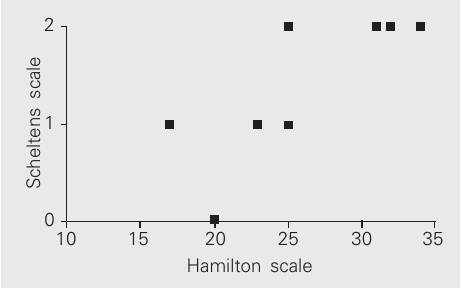
Figure 1. Distribution of scores on the Hamilton and Scheltens scales for subjects with heart failure and major depression for the frontal periventricular region. The correlation between severity of symptoms of de- pression and severity of scores on the Scheltens scale was statistically significant in this region (partial corre- lation coefficient = 0.79, P = 0.016, including age as a confounding covariate). Scores on the Scheltens scales were equal for both